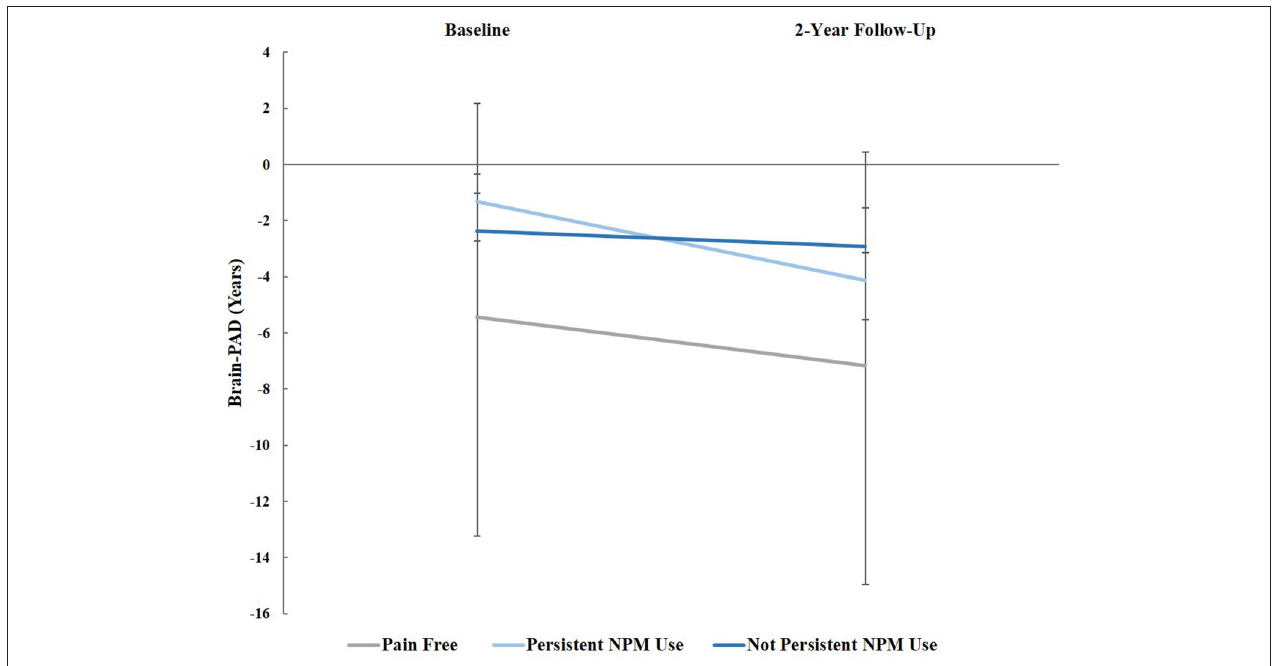
FIGURE 1 | Brain-PAD at baseline and 2-year follow-up across groups, controlling for age, sex, study site, and pain grade at both time points: Pain-free, those with chronic pain using non-pharmacological pain management (NPM), and chronic pain not using NPM. Error bars represent standard error.